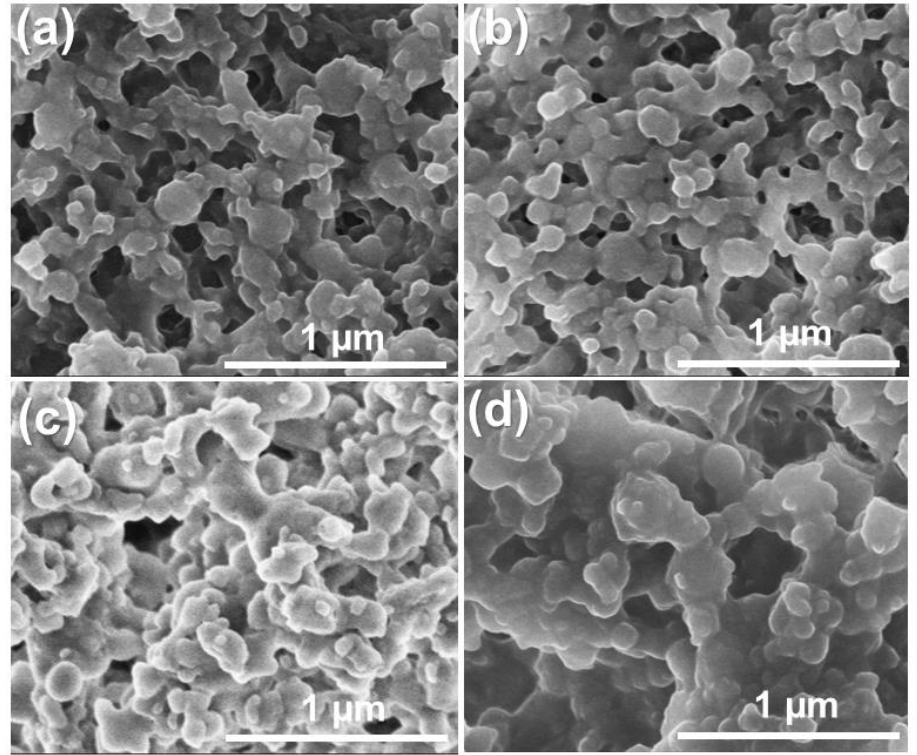
Figure 2. SEM images of Se NPs prepared from the CO extract under magnetic stirring condition with the Se 4+ /CO volume ratio of ( a ) 1/1, ( b ) 1/2, ( c ) 1/3, and ( d ) 1/4.